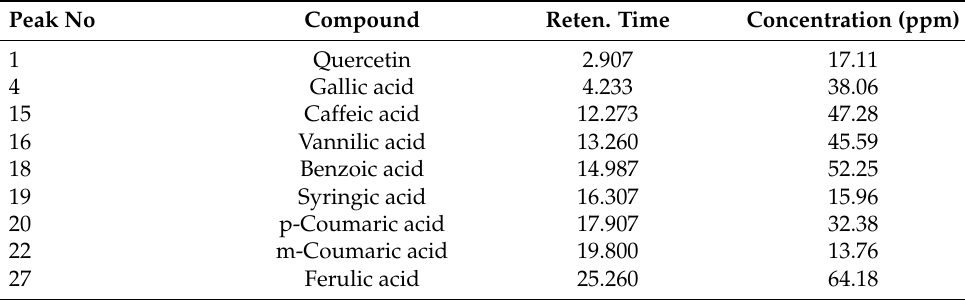
Table 2. Flavonoids and phenolic acids identified in T. aphylla by gradient HPLC. Peak No Compound Reten. Time